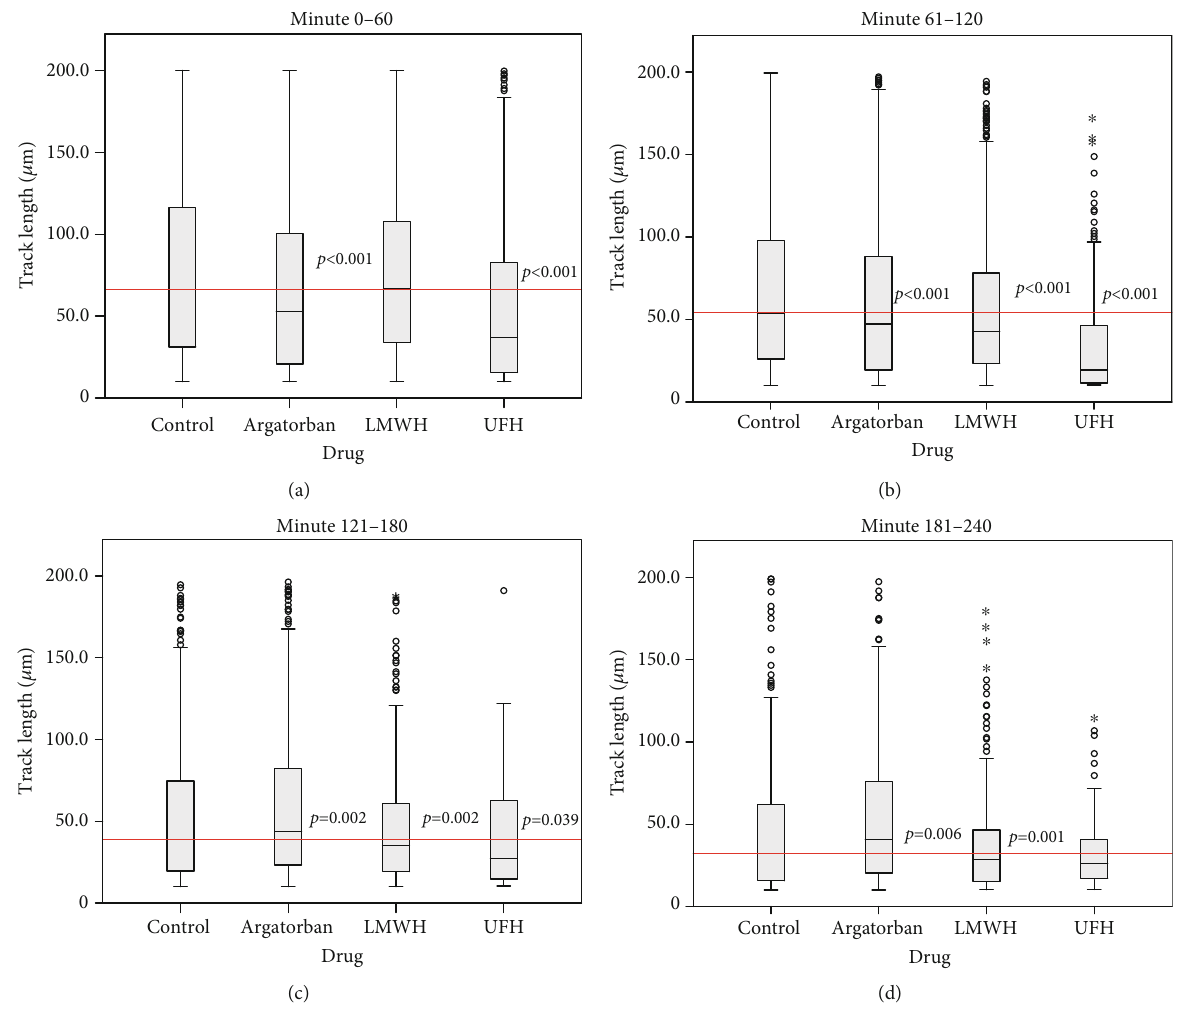
Figure 1: Comparison of track length medians of the verum groups with the control group at the observation time periods: 0 – 60min (a), 61 – 120 min (b), 121 – 180min (c), and 181 – 240min (d). Cont: control; Arga: argatroban; LMWH: low-molecular-weight heparin; UFH: unfractionated